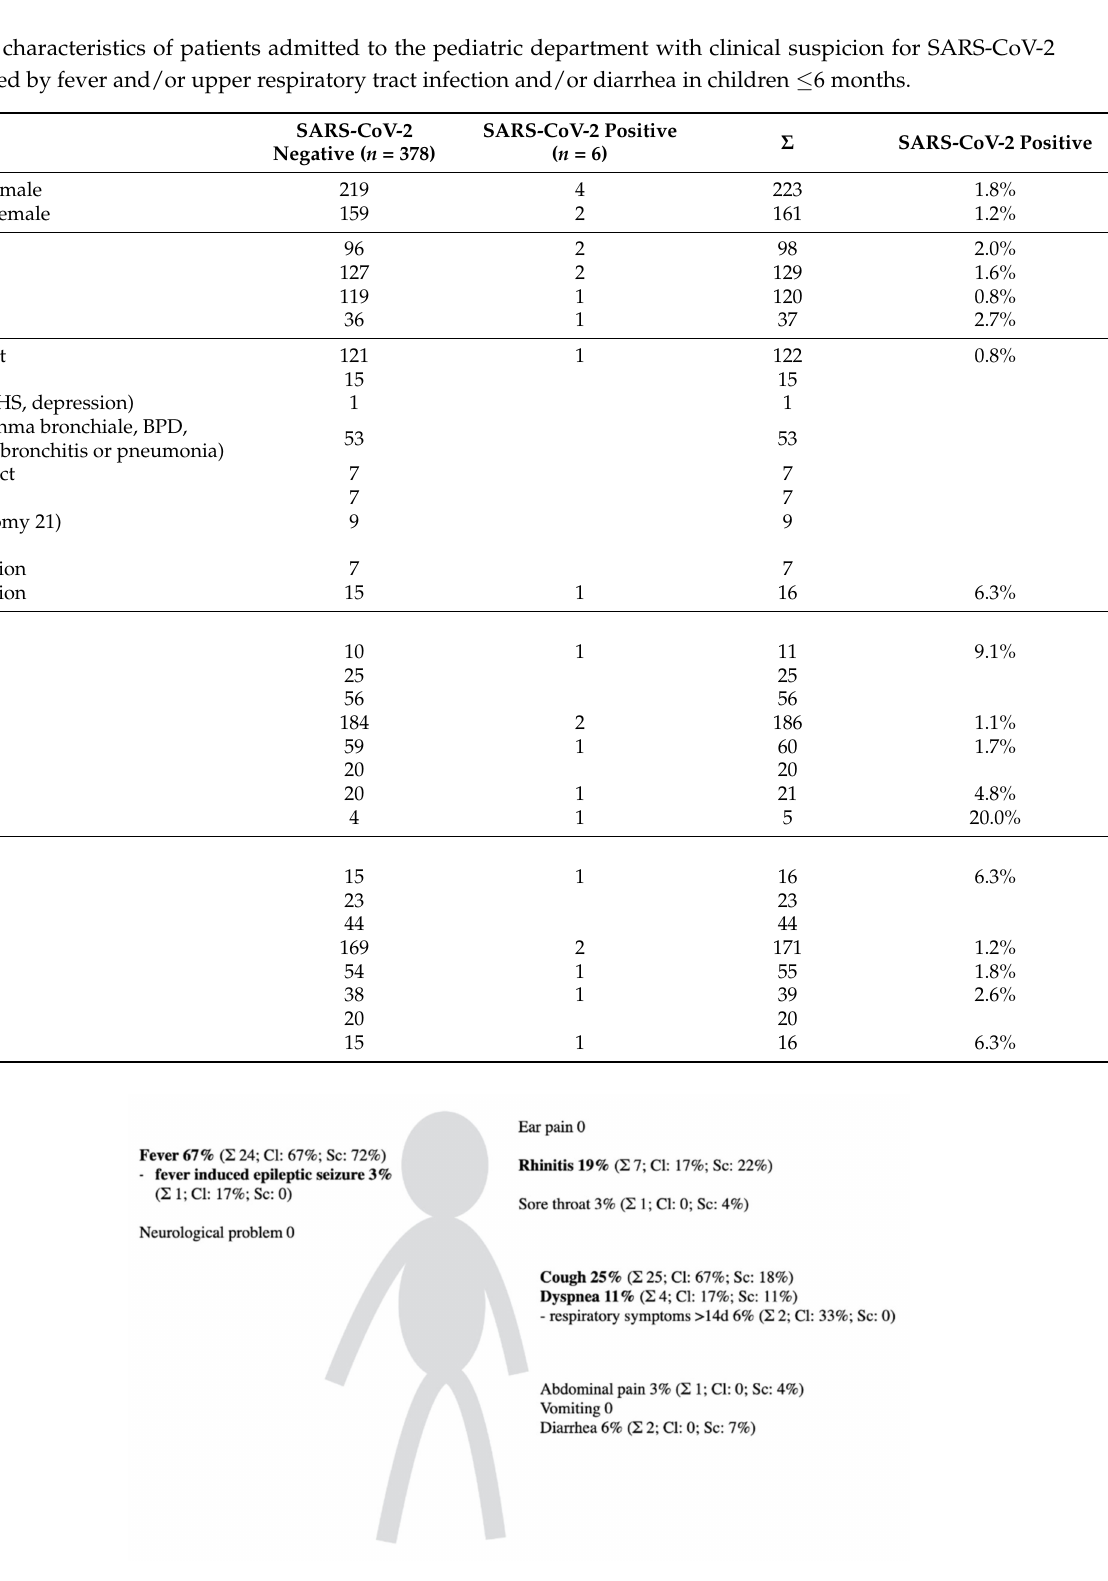
Figure 3. Clinical signs of SARS-CoV-2 infection in children in our cohorts. Numbers denote percentage of children from all age groups with the symptom among all infected children from cohort 1. In brackets, the total number of children with the clinical sign is given together with the percentage among positively tested during symptom-based screening of Cohort 2 March until September 2020 (total six) and unbiased screening since October 2020 (total